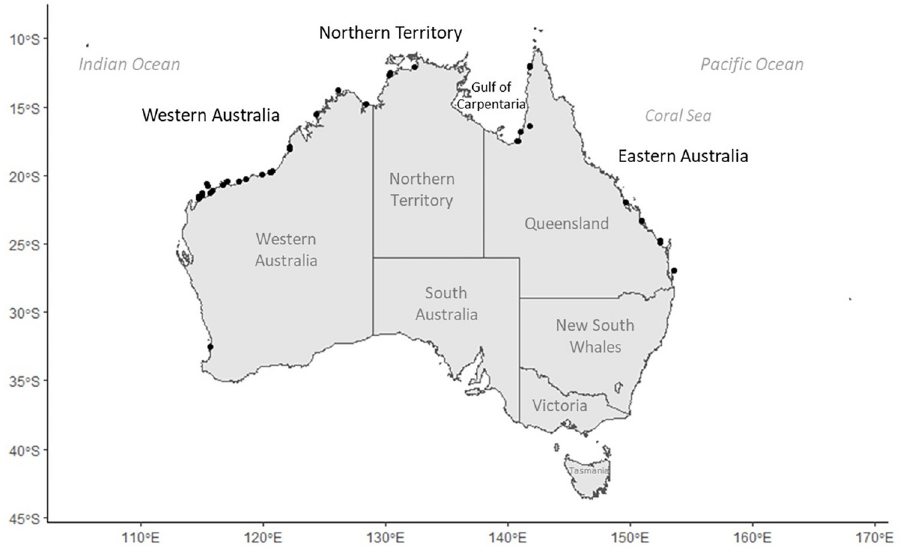
Fig 1. Study area. Map showing location of samples collected from 4 regions: Western Australia, Northern Territory, Gulf of Carpentaria, and Eastern Australia. (Map made using open source R software and R package ‘ggplot2’ (https:// github.com/tidyverse/ggplot2) and ‘ozmaps’ (https://github.com/mdsumner/ozmaps).